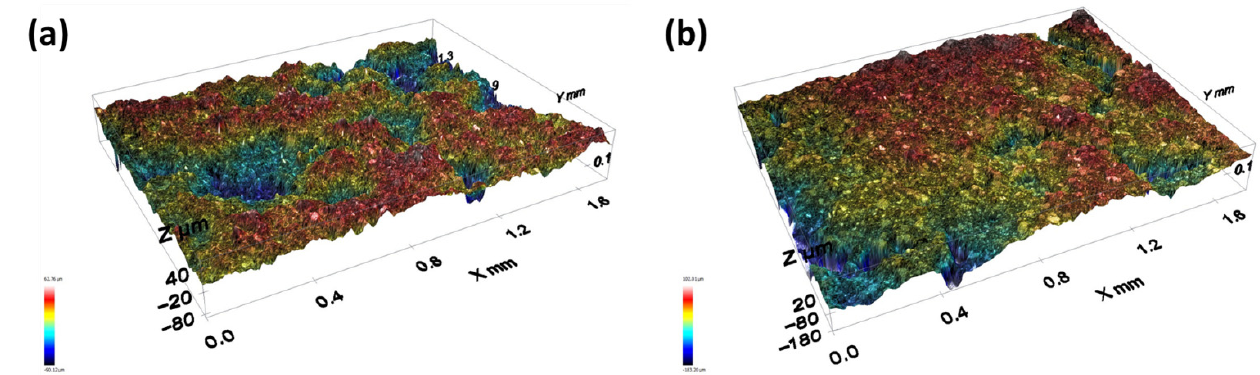
Figure 6. Surface topography curves obtained from Profilometer at ×10 objective lens. ( a ) 4Ir1Ni@AC—freshly made, R a (roughness parameter) 22.31 µm; ( b ) 4Ir1Ni@AC—after 15 h chrono- amperometry testing at − 1.16 V in 0.1 M NaOH electrolyte, R a (roughness parameter) 24.51 µm.